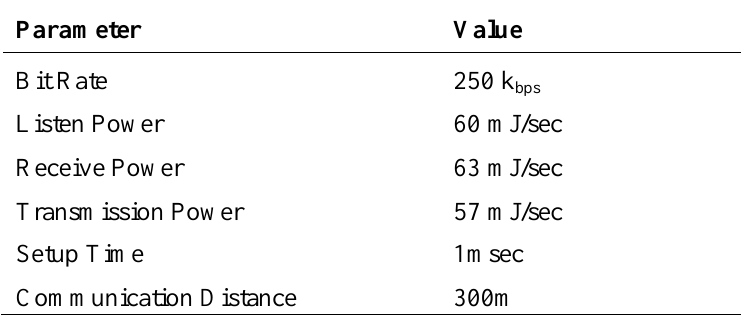
Table 1. CC2420 Transceiver